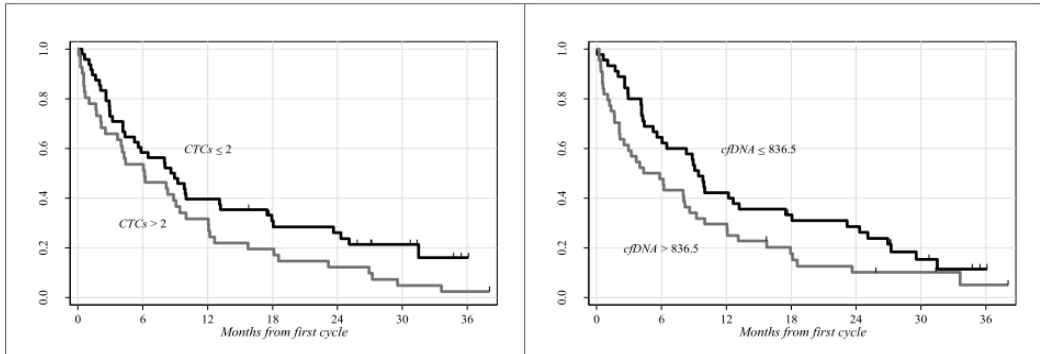
Figure 1. Clinical outcome estimated through the Kaplan-Meier analysis according to CTCs and cfDNA. Patients were categorized into two groups by means of the respective median baseline values. ( Left ): median survival times were 8.8 and 6.2 months for patients with ≤ 2 and > 2 CTCs / 3 mL of blood, respectively ( p = 0.05). ( Right ): median survival times were 9.4 and 5.1 months for patients with ≤ 836.5 and > 836.5 ng cfDNA / 3 mL of plasma, respectively ( p = 0.04).